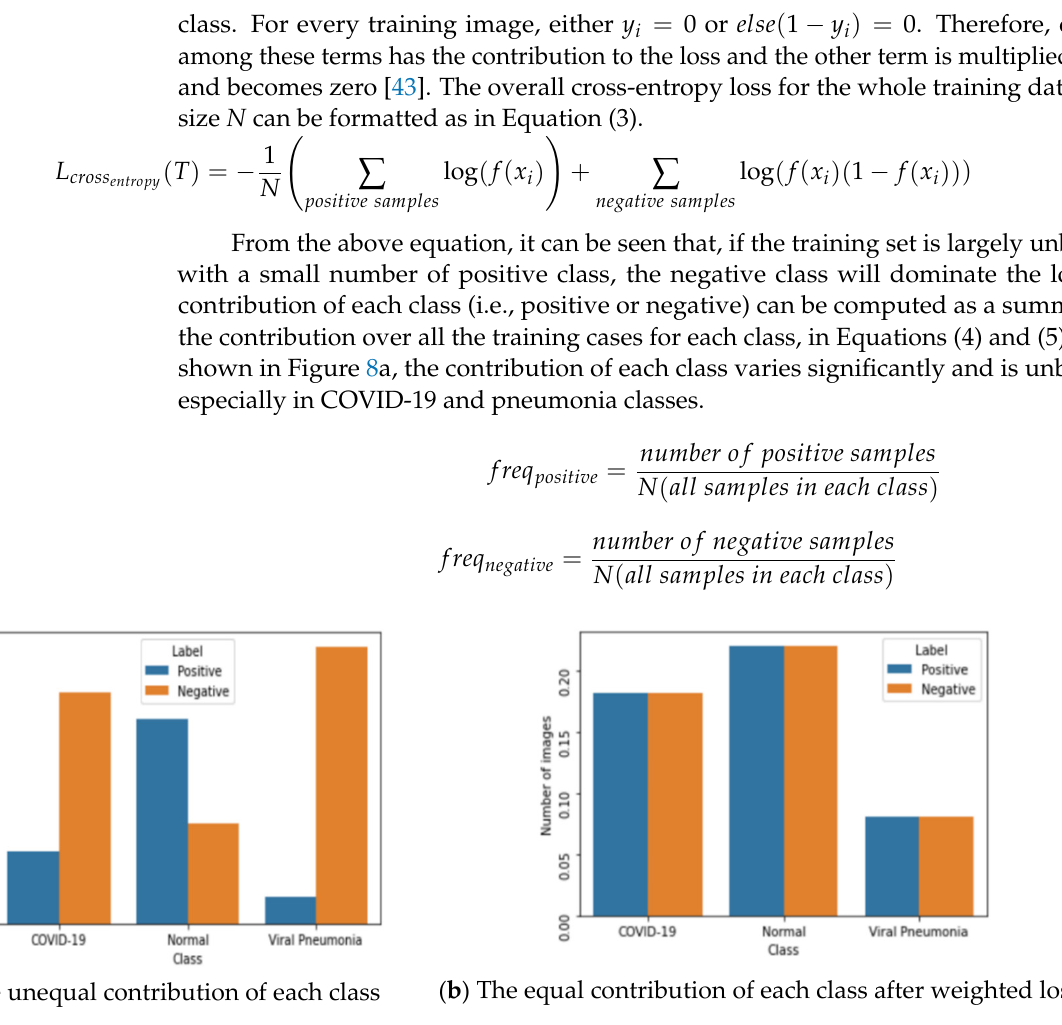
Figure 8. The contribution of positive and negative labels within each class.